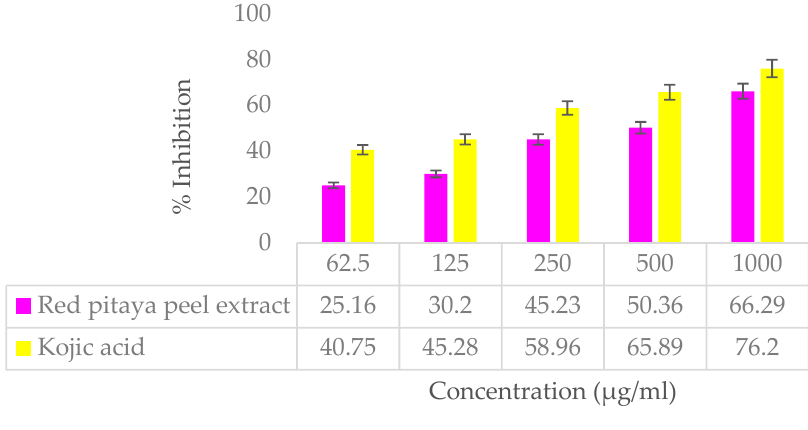
Figure 6. The percentage of tyrosinase inhibition of the optimized red pitaya peel extract (62.5–1000 µg/mL) and the standard solution of kojic acid.